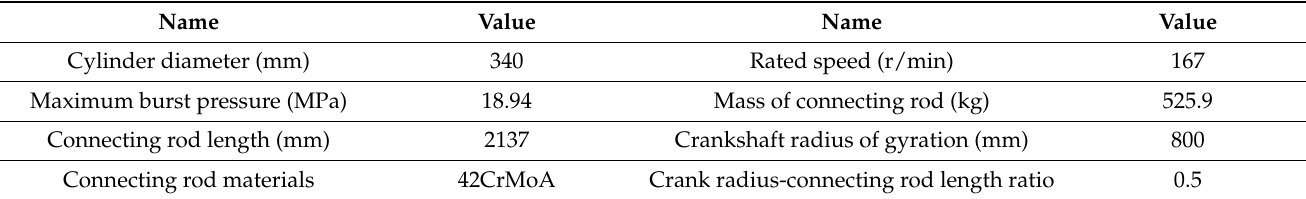
Table 1. Main parameters of connecting rod model